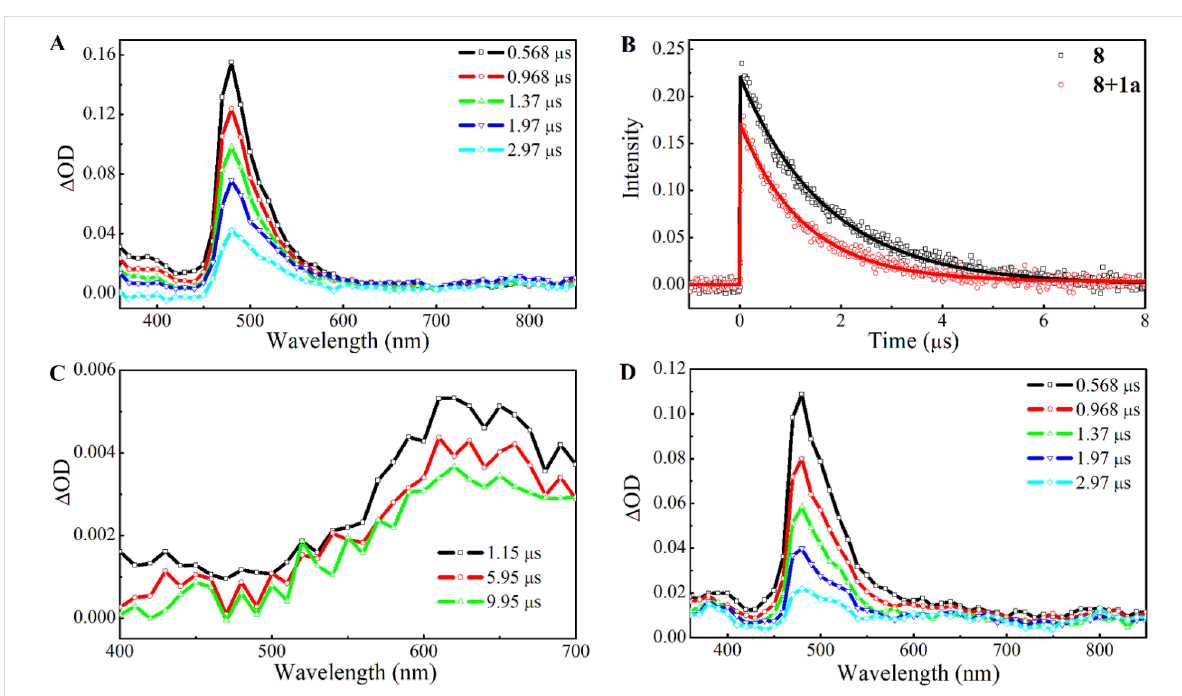
Figure 2: (A) ns-Transient absorption spectra of photocatalyst 8 in degassed DMSO recorded at different delay times (excitation wavelength = 355 nm). (B) ns-TA kinetic profile probed at 480 nm for photocatalyst 8 in the absence and presence of xanthate 1a . (C) and (D) ns-Transient absorp- tion spectra of xanthate 1a and 8 in the presence of 1a in degassed DMSO recorded at different delay times, respectively (excitation wavelength = 355